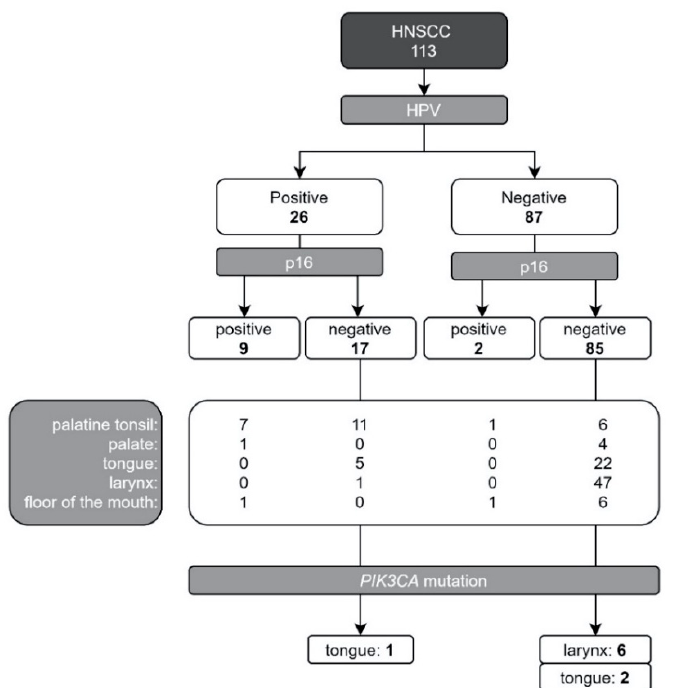
Figure 1. Study group constitution considering tumor primary location and genetic testing results ( PIK3CA H1047R mutation, HPV infection and p16 protein expression; Abbreviations: HNSCC—head and neck squamous cell carcinoma, HPV—human papilloma virus, PIK3CA -phosphatidylinositol-4,5-bisphosphate 3-kinase catalytic subunit alpha gene).